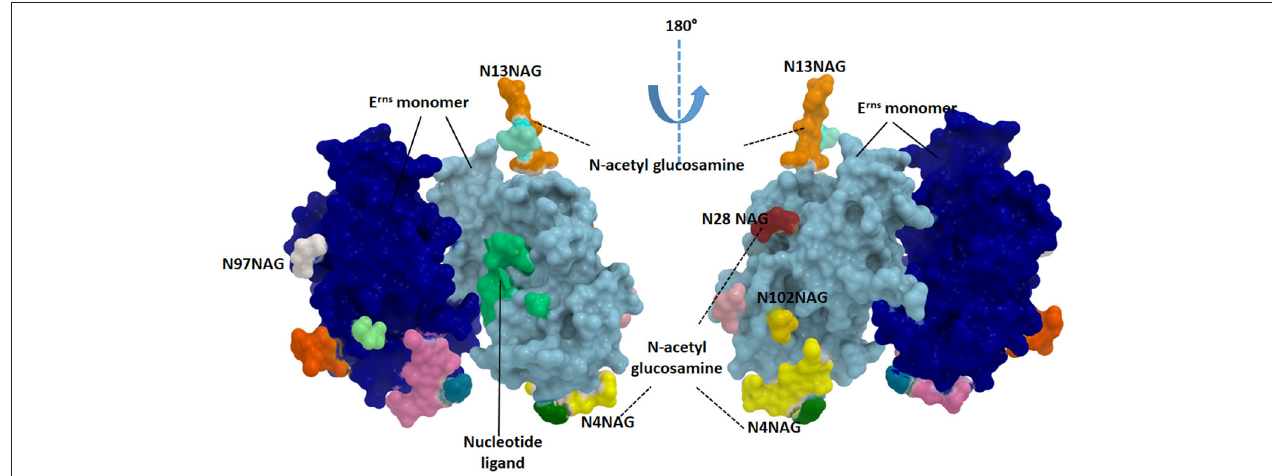
FIGURE 3 | Structure of the catalytic domain of envelope E rns glycoprotein. Each monomer is showing in blue and cyan colors. The glycosylated sites are provided in green (N4NAG), orange (N13NAG), red (N28NAG), white (N97NAG), and yellow (N102NAG). The figure was derived from the structure deposited in the protein data bank (PDB ID 4dvn).